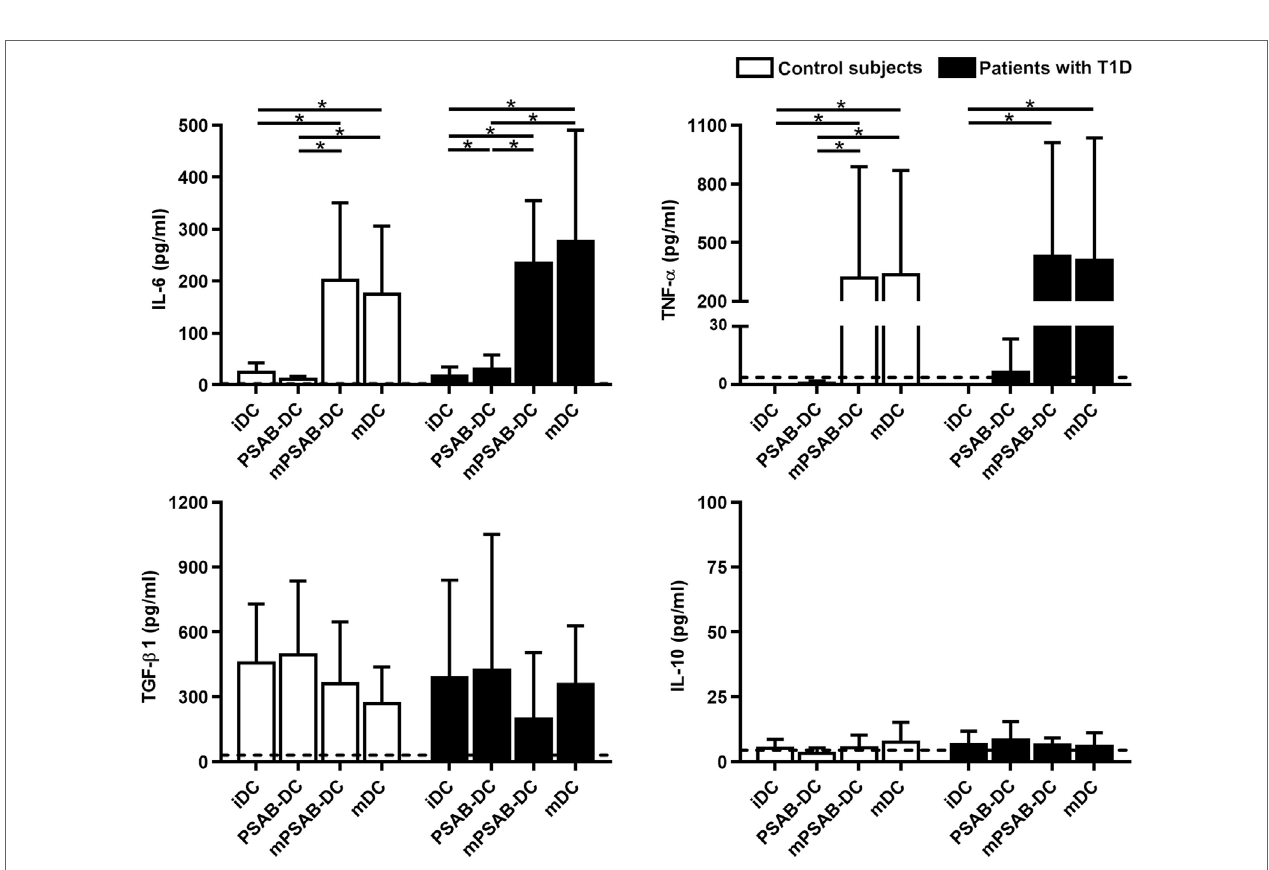
FigUre 3 | Capture of PSA-liposomes and PSB-liposomes regulates dendritic cell (DCs) phenotype. Relative CD36, TIM4, Integrin α v β 5, HLA-ABC, HLA-DR, CD54, CD40, CD86, CD25, CCR7, CCR2, CXCR4, TLR2, CD14, and DC-SIGN membrane expression in DCs obtained from control subjects (white bars, n ≥ 5) and patients with type 1 diabetes (T1D) (black bars, n ≥ 8). Bars represent immature DCs (iDCs), iDCs after the capture of PSA-liposomes and PSB-liposomes (PSAB-DCs), mature PSAB-DCs (mPSAB-DCs), or mature DCs (mDCs), 24 h after culture. MDCs were induced by culture with cytokine cocktail. Data presented as mean ± SD of relative Median of Fluorescence Intensity (MFI), this being MFI of each culture condition referred to their respective mDCs control. Significant differences were found when comparing culture conditions in the same group of subjects (* p ≤ 0.05, ** p < 0.01, *** p < 0.001, **** p < 0.0001, Wilcoxon test), and when comparing the same culture conditions between patients with T1D and control subjects ( + p < 0.05, Mann–Whitney